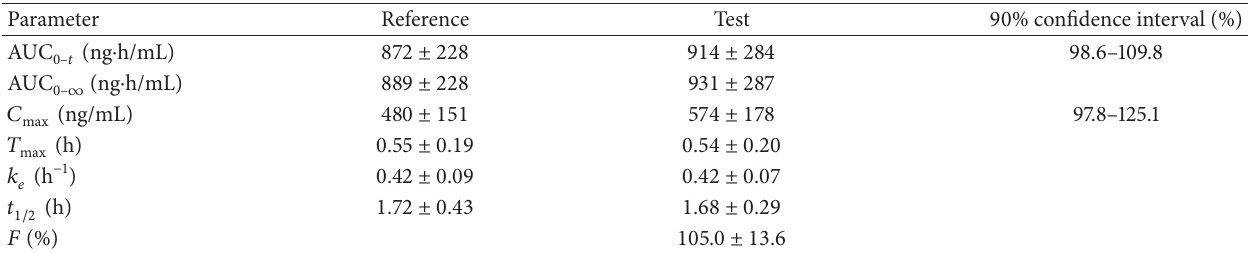
Table 3: The main pharmacokinetic